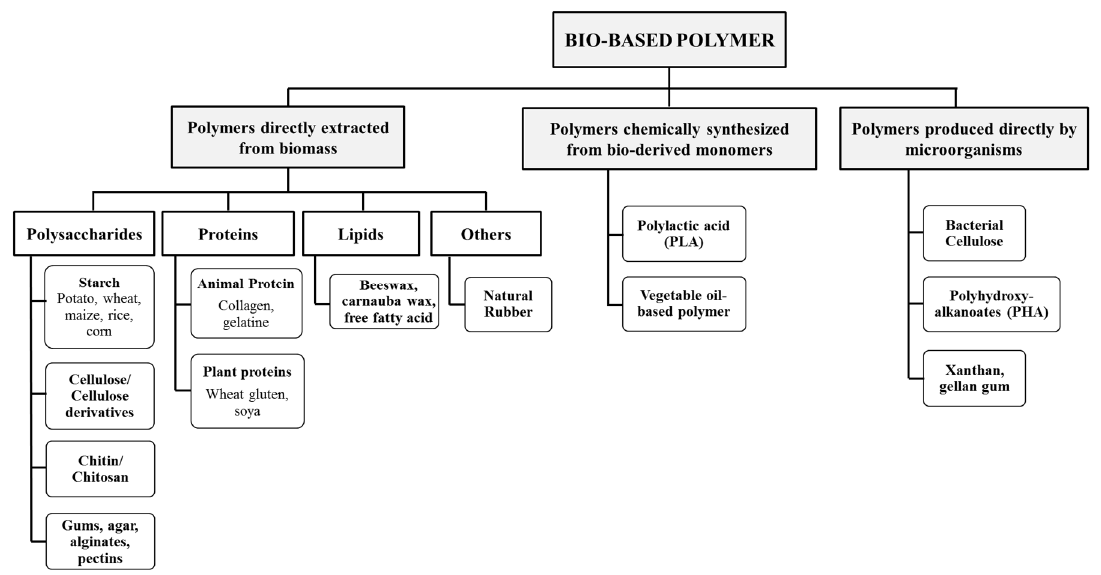
Figure 1. Classification of bio-based polymer (adapted from Malhotra et al. [2]). Table 1. Various types of bio-based polymers, their sources, and uses [3].